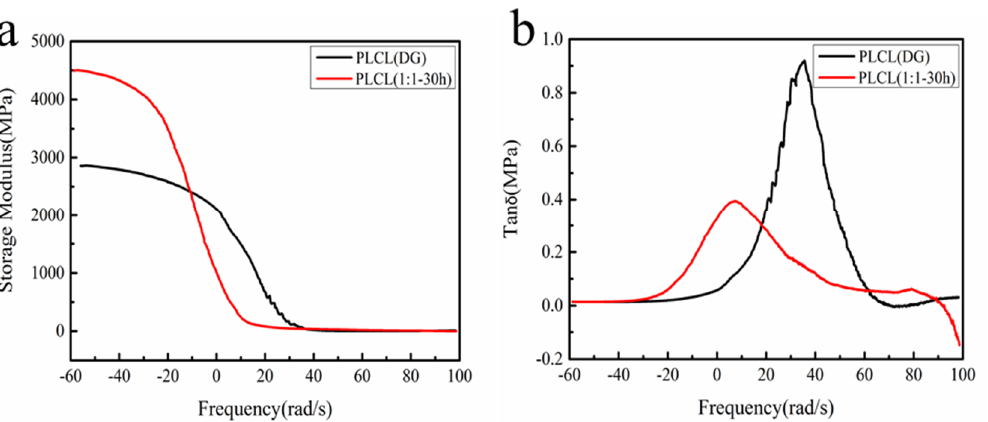
Figure 9. Temperature dependence of the dynamic mechanical spectra for the storage modulus ( a ) and tan δ ( b ) for PLCL (DG) and PLCL (1:1 - 30 h).